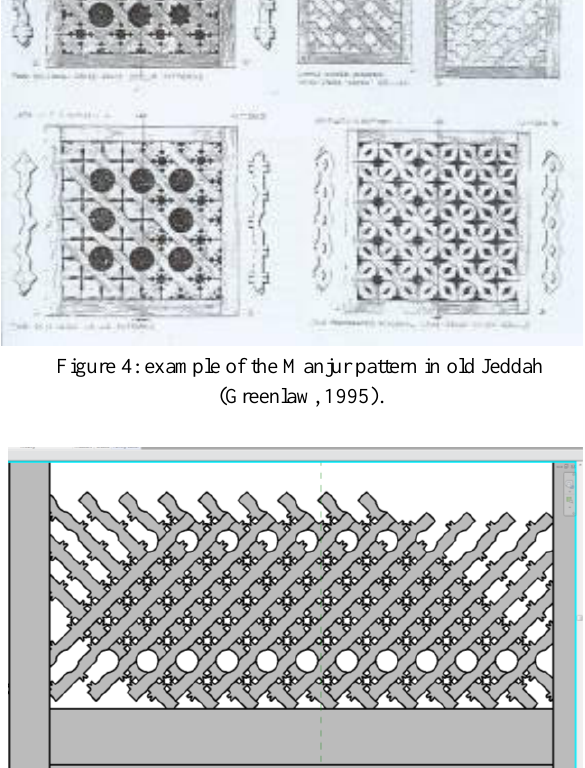
Figure 5: modelling the Manjur pattern in “HAOL” Library